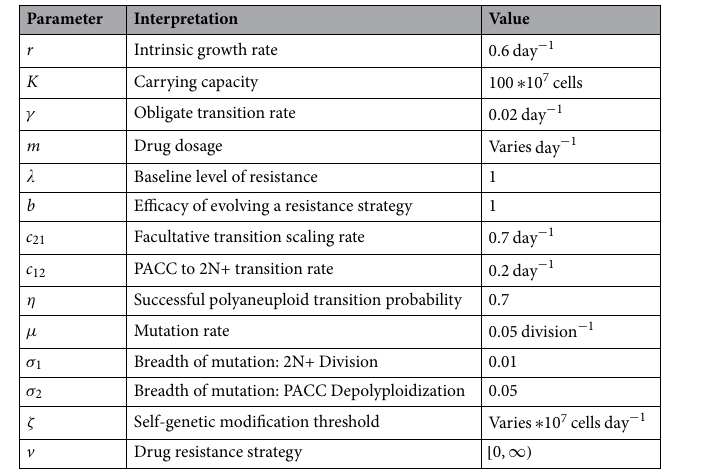
Table 1. Parameter definitions and values used in